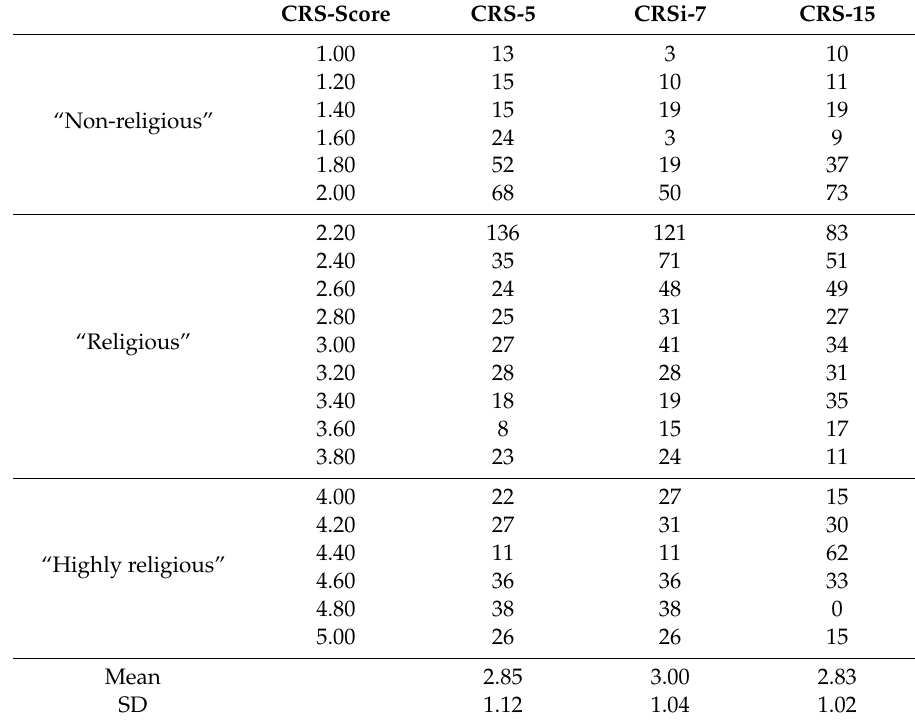
Table A4. Norm values of CRS-5, CRSi-7, and